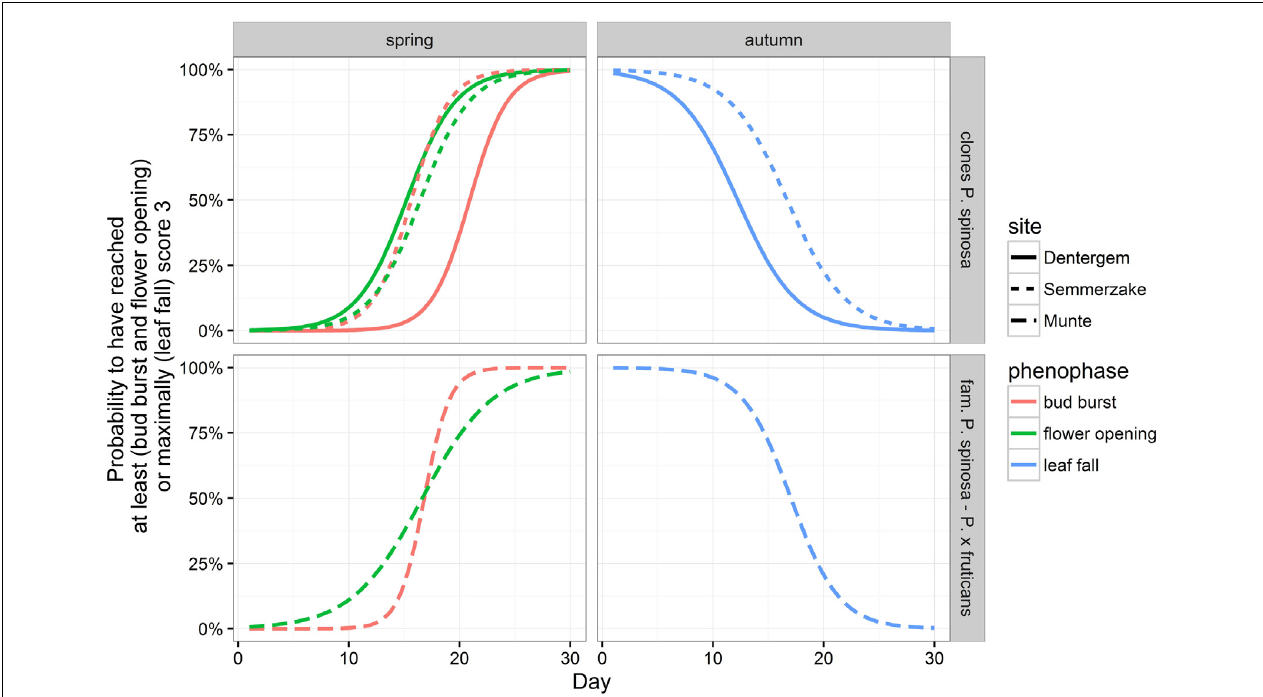
FIGURE 5 | Modeled phenological responses (bud burst, flower opening, and leaf fall) in the clone and family plantations. Score levels for the different phenophases are in Table 3 . Day 1 in spring is March 26 and day 1 in autumn September 23.